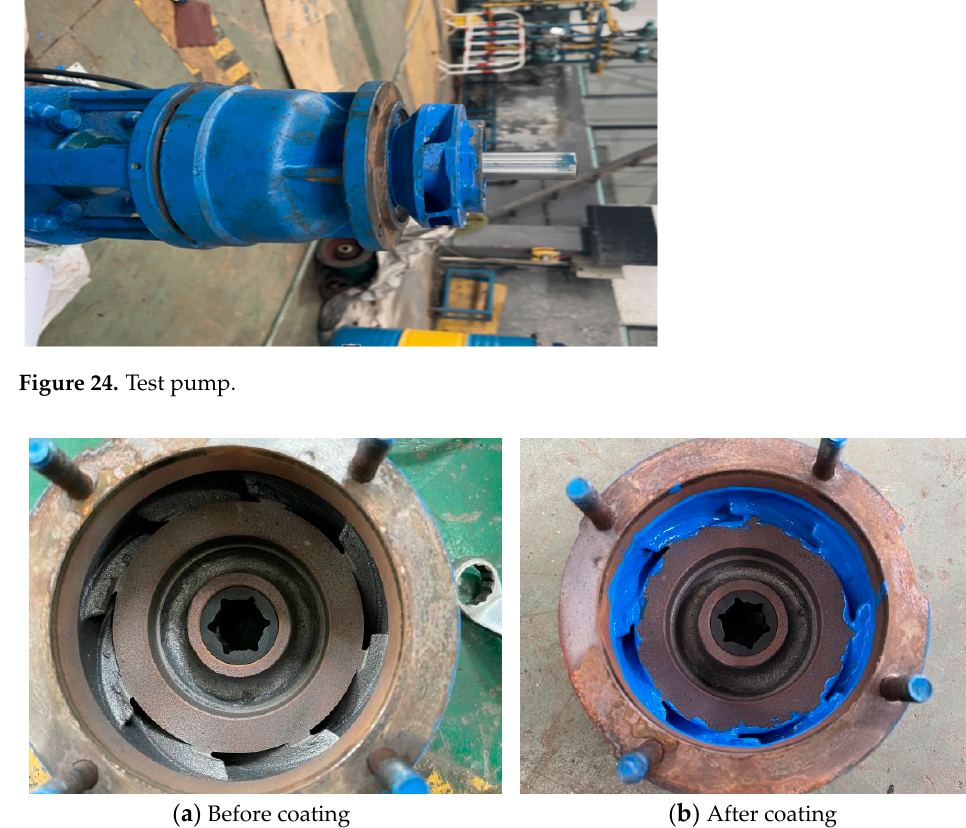
Figure 25. Comparison chart of guide vanes of test pump before and after coating. The test site during the test is shown in Figure 26.